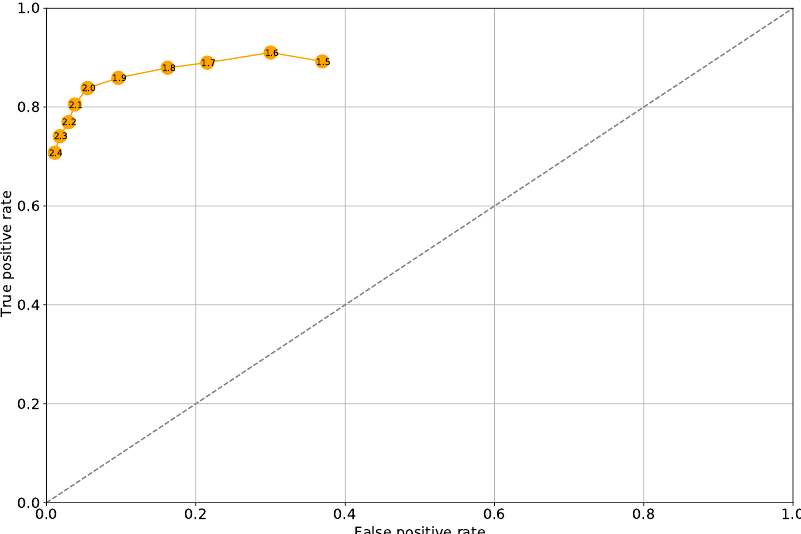
Figure 7. Receiver operation characteristic (ROC) for the MC-LSTM-12 model with thresholds (inscribed in tags) taken from the range (1, 2; 2, 1).